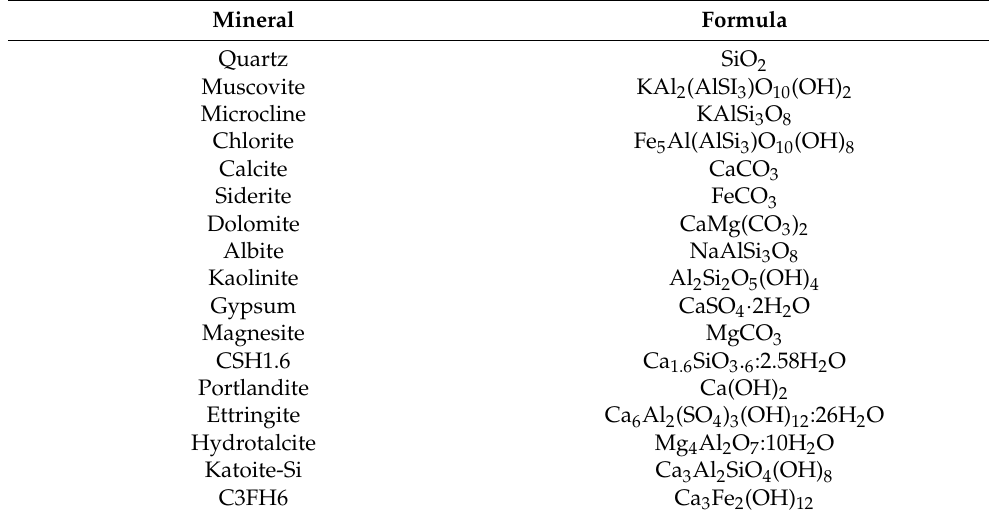
Table 7. Mineral phases used in the